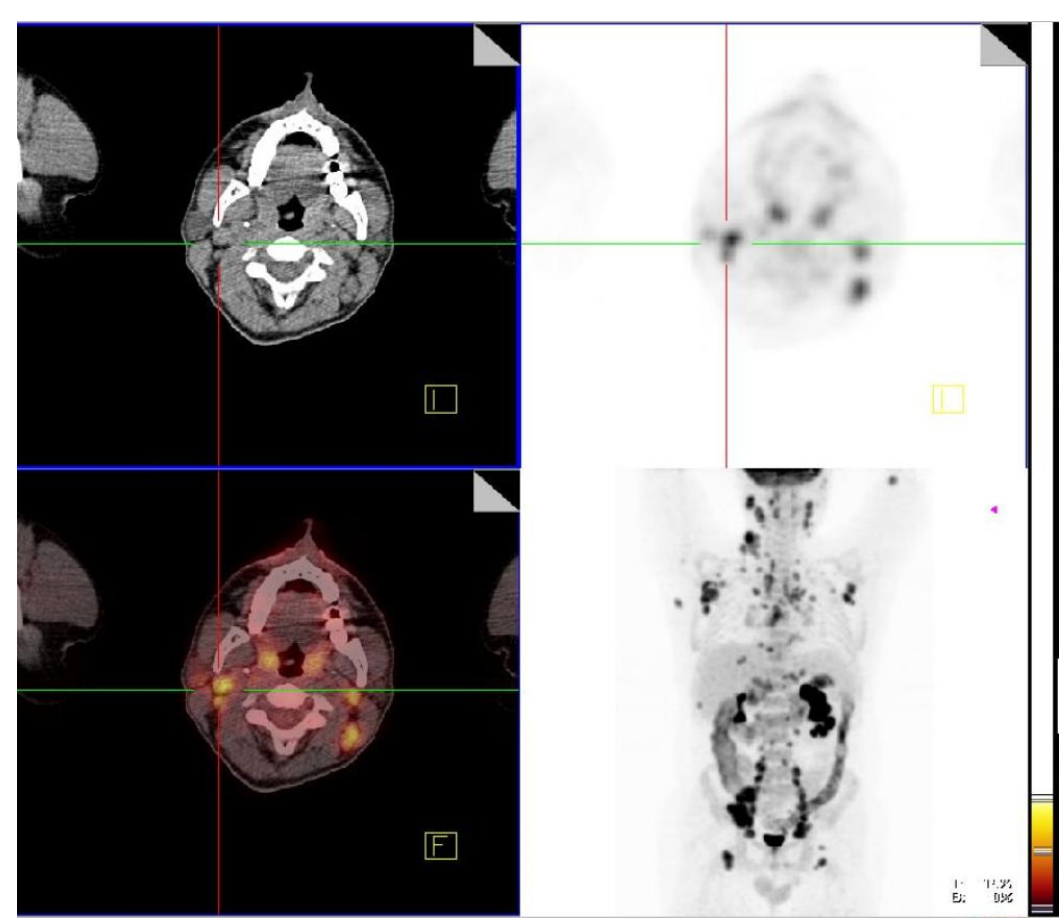
Figure 5. Wide spread disease, active sarcoidosis in cervical lymph nodes, axilar lymph nodes, mediastinal lymph nodes, lungs, liver, spleen, retroperitoneal and paraortal lymph nodes.